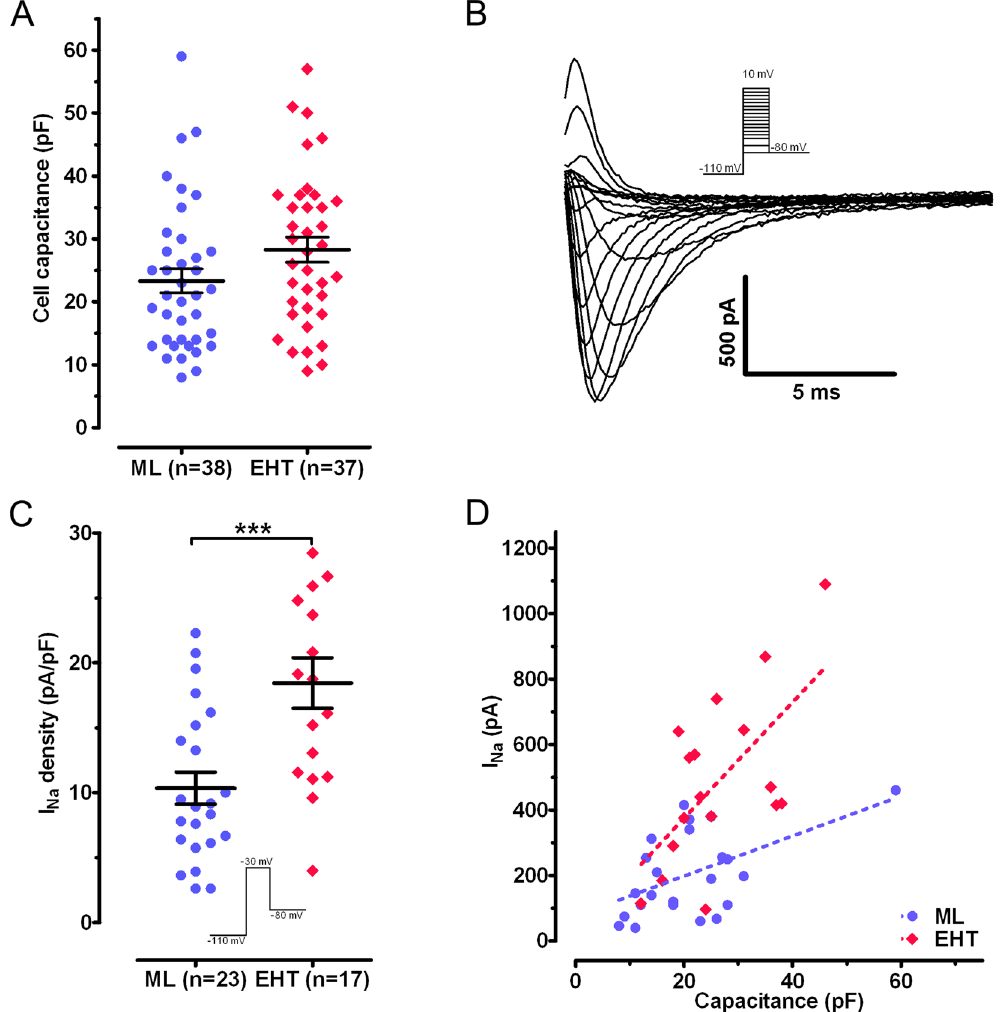
Figure 1. Cell capacitance and sodium current. ( A ) Scatter plot of cell capacitance in hiPSC-CM (mean values in Table 1). ( B ) Family of original Na current traces elicited by the protocol shown in the inset. ( C ) Scatter plot of I Na density in hiPSC-CM for voltage-clamp pulse to − 30 mV from a holding potential of − 110 mV (EHT vs ML: *** p < 0.001). ( D ): Correlation of I Na amplitude and cell capacitance. Best fit values for slope: ML 9.7 ± 2.4 pA/pF vs. EHT 16.9 ± 5.9 pA/pF. Deviation from zero slope was significant for ML (p < 0.001) and EHT (p <